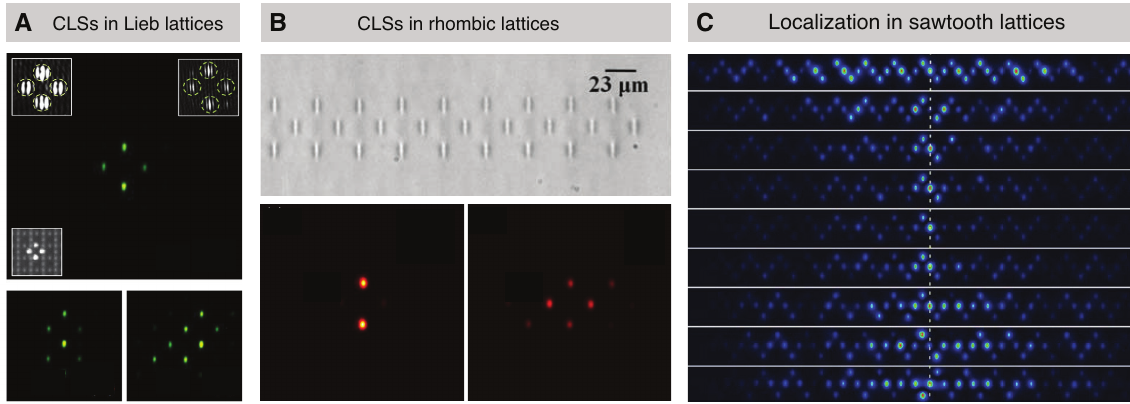
Figure 4: Examples of the compact localized states observed in fs-laser-written flat-band photonic lattices. (A) The CLSs and their superimposed bound states observed in a Lieb lattice [32]. (B) The CLSs and the equal-phase modes observed in a